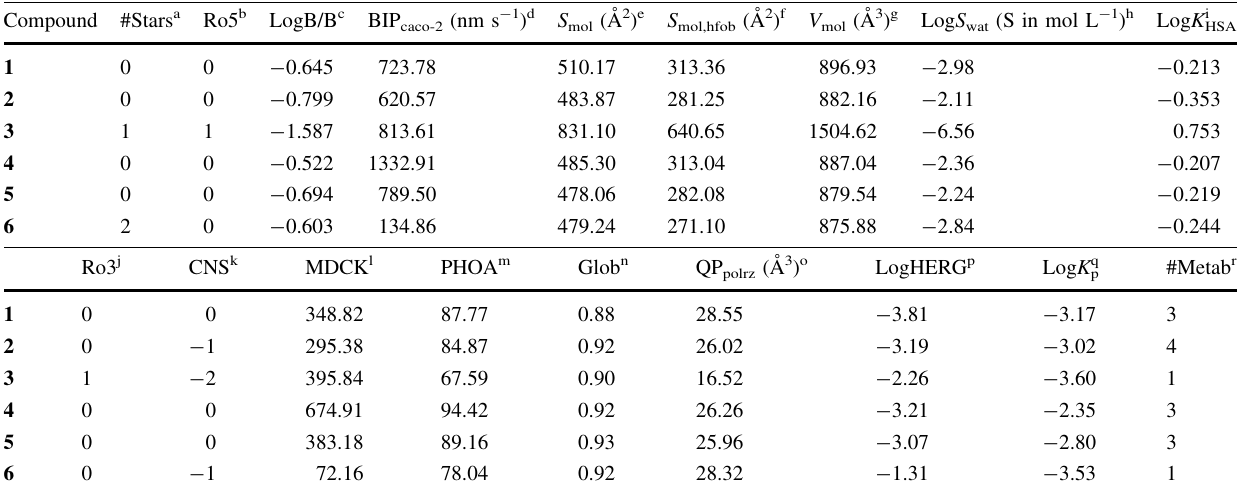
Table 7 Summary of the predicted physicochemical parameters used to access the pharmacokinetic properties of compounds 1 –